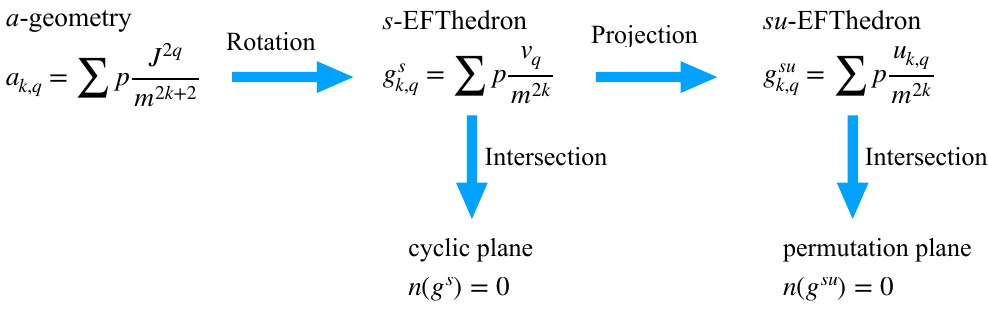
Figure 1 . Deriving s - and su -EFThedrons from a